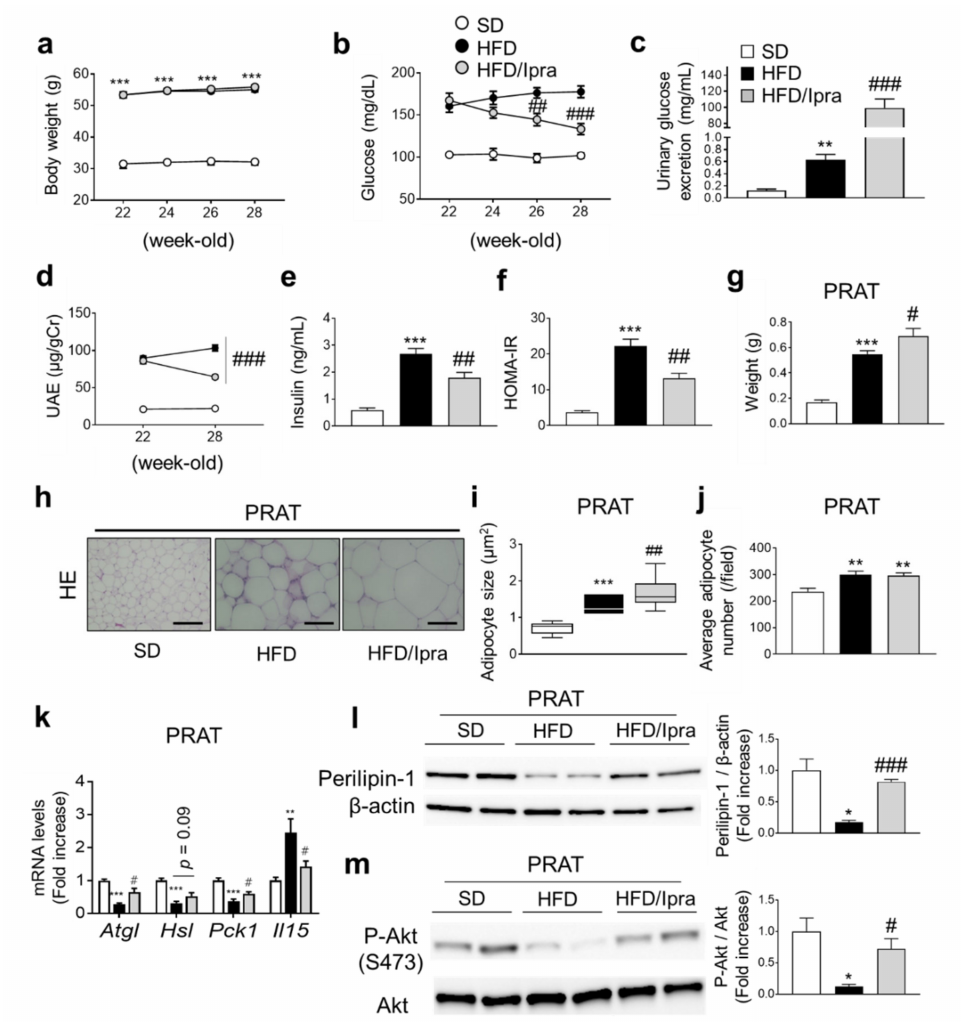
Figure 1. Ipra ameliorates HFD-induced urinary albumin excretion associated with increased adipocyte size and enhanced insulin signaling in PRAT. Changes in ( a ) body weight and ( b ) blood glucose in SD- or HFD-fed WT mice during treatment with or without Ipra from 22 to 28 weeks of age. ( c ) Urinary glucose excretion after 3 weeks of Ipra treatment. ( d ) Changes in urinary albumin excretion (UAE) before and after Ipra treatment for 6 weeks. ( e ) Fasting plasma insulin concentration, ( f ) HOMA-IR, and ( g ) PRAT weight after 6 weeks of Ipra treatment. ( h ) Hematoxylin and eosin staining and quantification of ( i ) adipocyte size and ( j ) number of adipocytes per field in PRAT. ( k ) Expression levels of lipolysis- and lipogenesis-related genes in PRAT of SD- or HFD-fed WT mice after 6 weeks of Ipra treatment. Representative blots and quantitative data of ( l ) perilipin-1 and ( m ) insulin-induced Akt phosphorylation (p-Akt) in PRAT. WT, wild-type; SD, standard diet; HFD, high-fat diet; Ipra, ipragliflozin; PRAT, perirenal adipose tissue; HOMA-IR, homeostatic model assessment for insulin resistance. Scale bar, 1 µ m. Original magnification, × 200. * p < 0.05, ** p < 0.01, *** p < 0.001 vs. SD. # p < 0.05, ## p < 0.01, ### p < 0.001 vs. HFD. n = 6 ( a – d , g , k ) n = 9–11 ( e , f , i , j